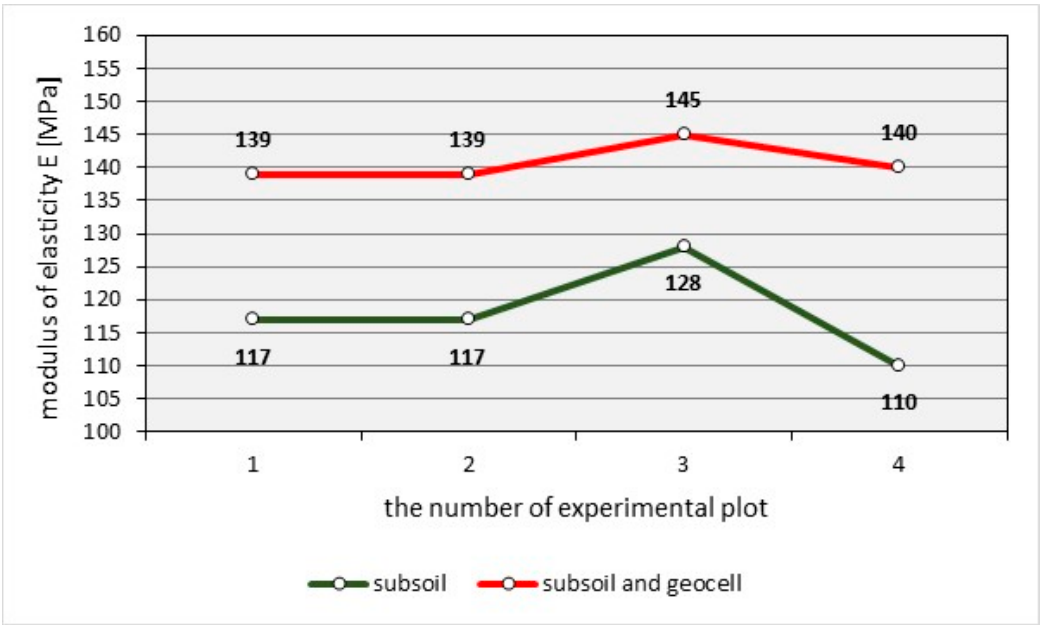
Figure 25. Comparison of the values of the modulus of elasticity obtained on the subsoil and on the structure of the natural pavement with airfield geocell.